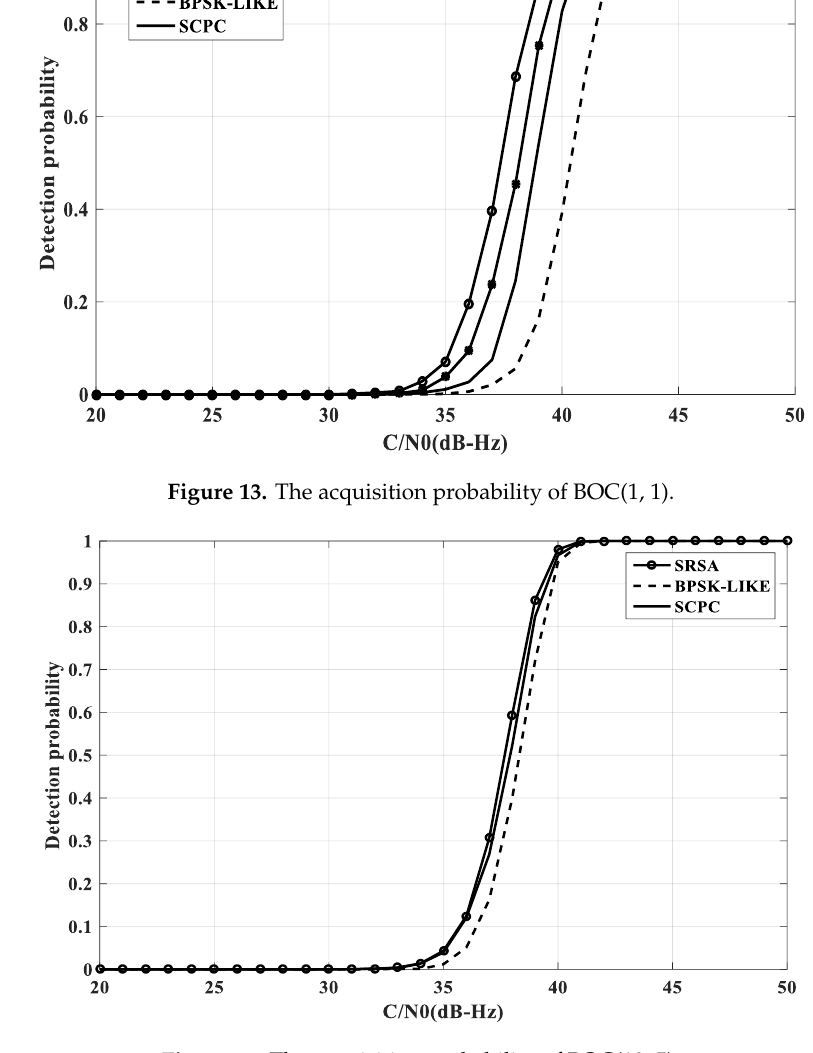
Figure 14. The acquisition probability of BOC(10, 5).